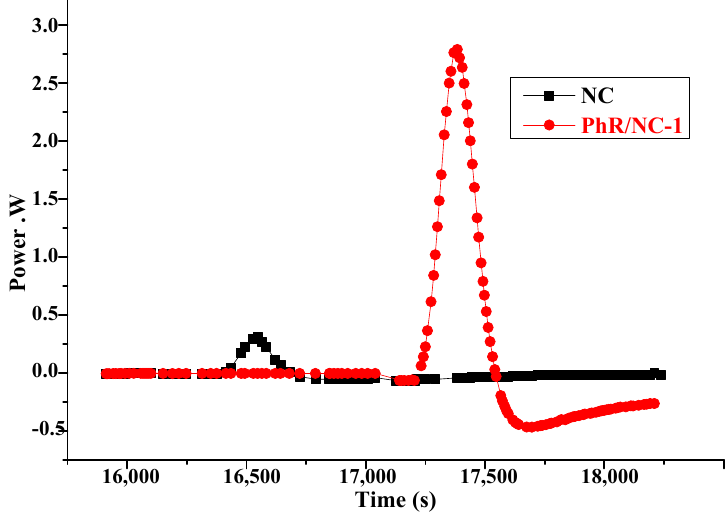
Figure 7. Heating power of the calorimeter during release of heat of ARS adsorption on NC carbon and PhR/NC-1 composite.